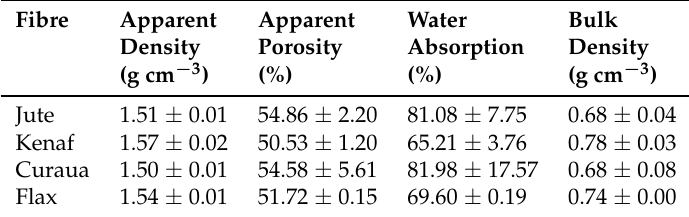
Table 1. Physical properties of jute, kenaf, curaua, and flax fibres. Errors represent standard errors of means